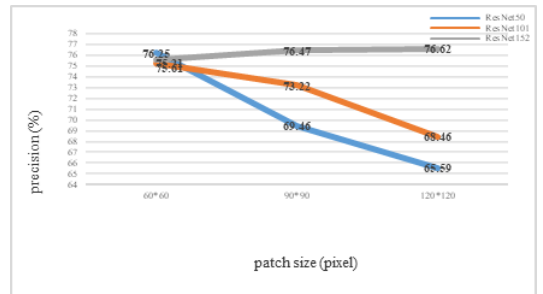
Figure 8 . Ground